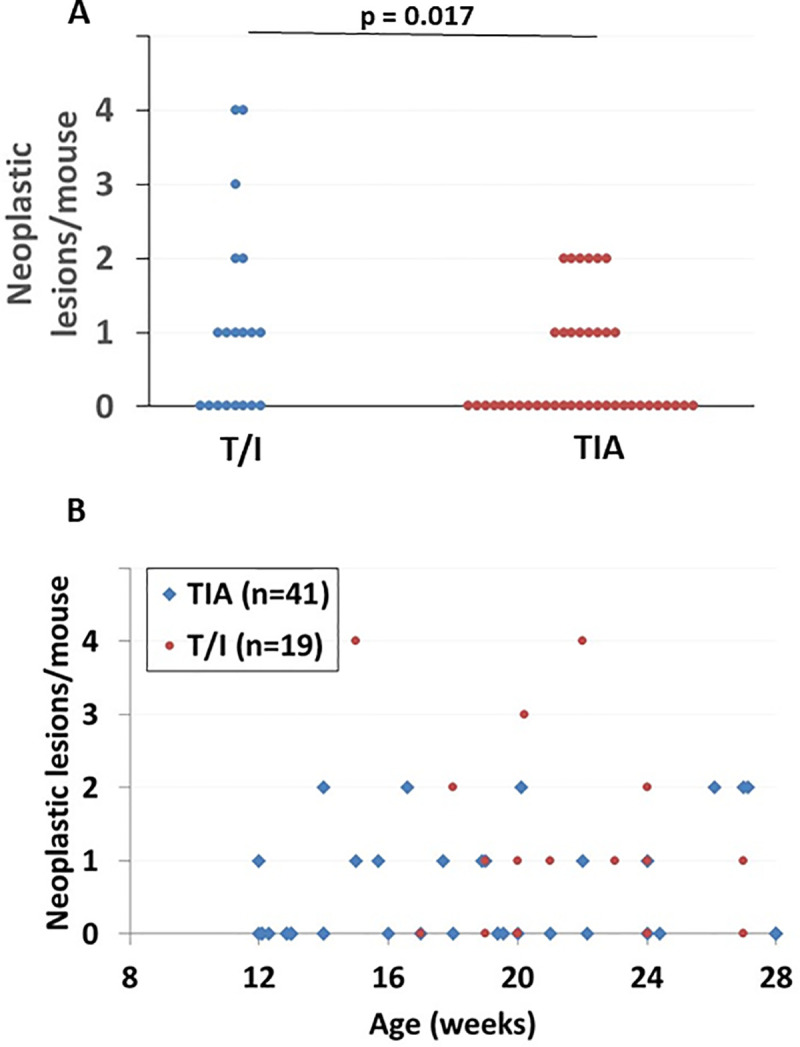
Incidence and multiplicity of colonic neoplasia in T/I versus TIA mice.A. The number of tumors per mouse is shown for T/I (n = 19) and TIA mice (n = 41). Each point represents a single mouse. The p value shown is the result of a multivariable analysis that adjusted for age when neoplasia was ascertained (Poisson regression analysis). B. The number of tumors per mouse is shown as a function of age at euthanasia for the same cohort illustrated in panel A. Each point represents a single mouse, however some points are not visible due to multiple mice with the same age and tumor count.